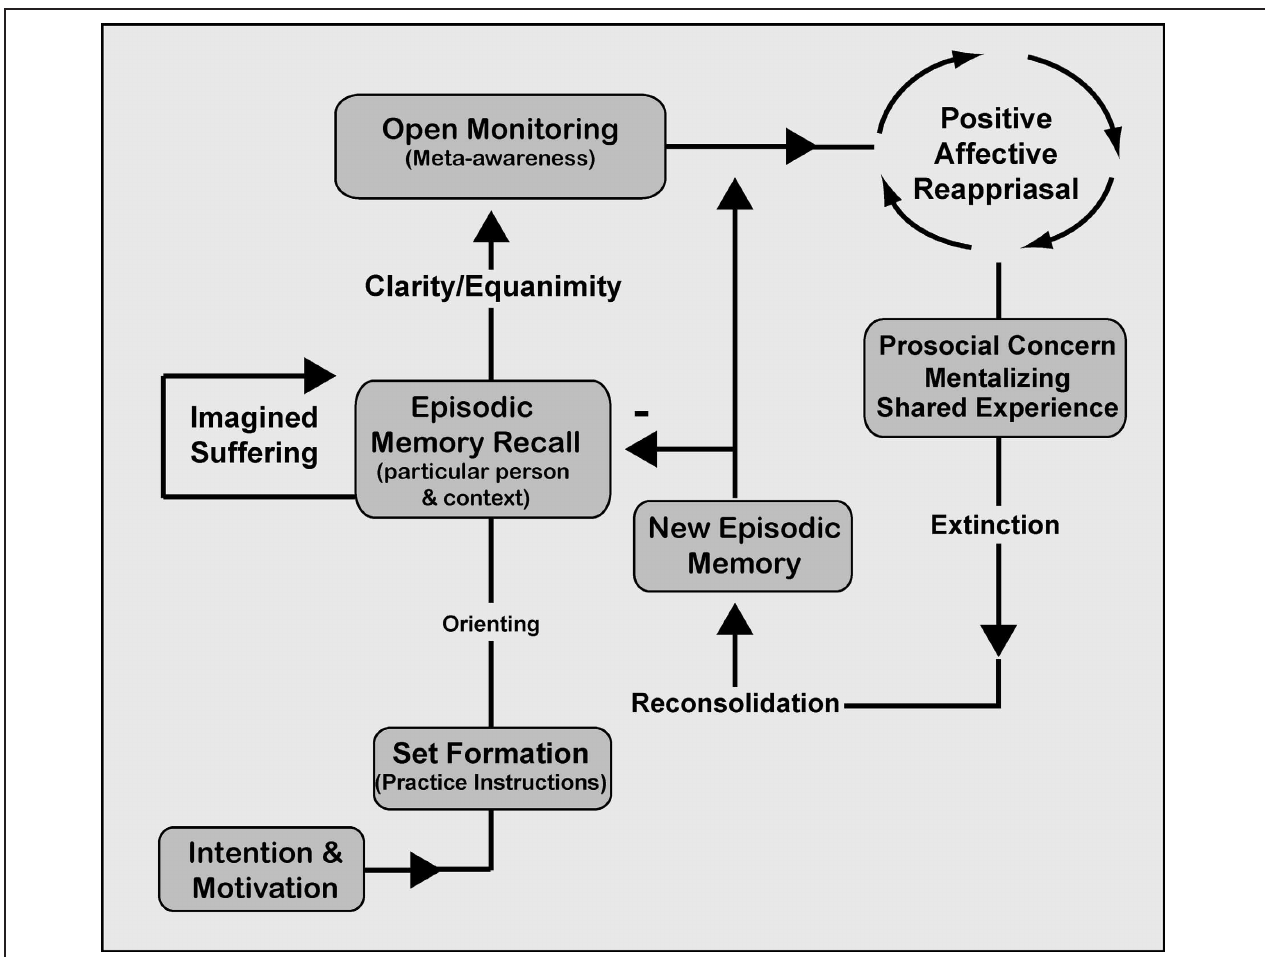
FIGURE 5 | Mindfulness process model. Ethical-enhancement (EE) practice. Intention is formed along with motivation to practice before an executive “set” is created within the working memory system in order to implement and maintain practice instructions. Focused attentional networks are recruited for orienting toward sustained episodic memory recall involving mentalizing and shared experience. OM practice is described to supplement EE practice facilitating awareness of any modality of experience that arises. The processes are proposed to be the same across ethical styles of practice that require imagined suffering or a particular declarative memory [of someone or something]. Mentalizing one’s own or